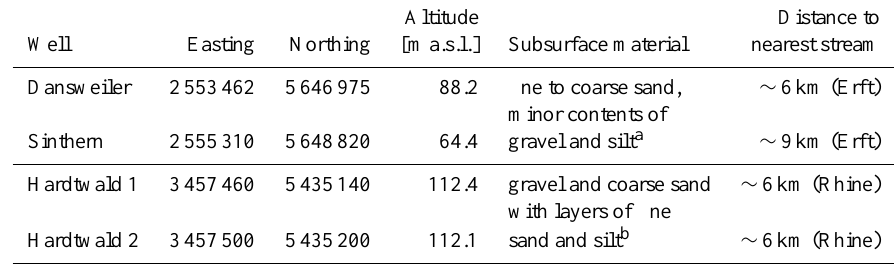
Table 2. Hydrogeological data of the four observation wells. Depth of Depth of Average Groundwater water table well screens hydraulic recharge Well [mb.g.l]